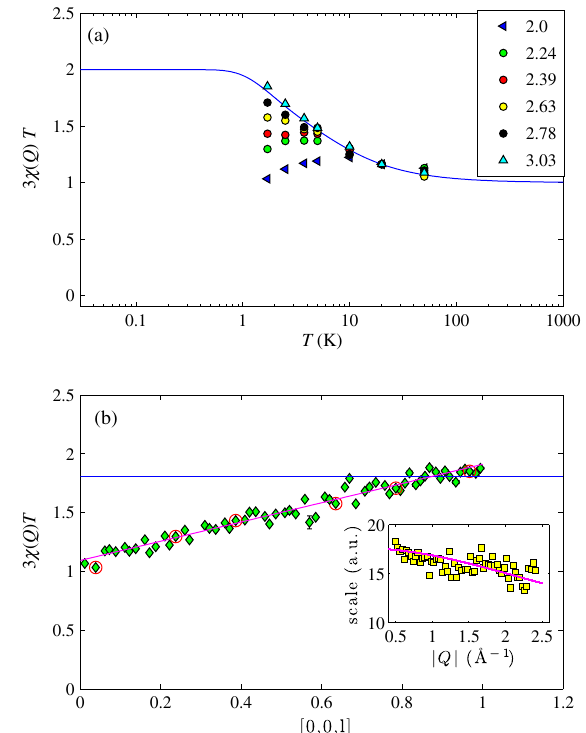
FIG. 7. Wave-vector dependence along the ½ 0 ; 0 ; ‘ (cid:9) ridge. Panel (a): Temperature dependence of S ð Q ; T Þ at points on ½ 0 ; 0 ; ‘ (cid:9) scaled to the predicted susceptibility at 20 K. Panel (b): S ð Q ; T Þ vs ð ‘ (cid:1) 2 Þ ¼ ð a= 2 (cid:2) Þj Q j centered at [0,0,2] at 1.7 K. Blue line: Theoretical value at this temperature, from Eq. (1); the pink line in (b) is a guide to the eye. All data points along ½ 0 ; 0 ; ‘ (cid:9) are folded into a single Brillouin zone, and those ringed in red correspond to the temperature series in panel (a). The inset shows the scale factor for individual points on ½ 0 ; 0 ; ‘ (cid:9) compared to the squared magnetic form factor j f ð Q Þj 2 as a function of Q at 20 K. (See text for